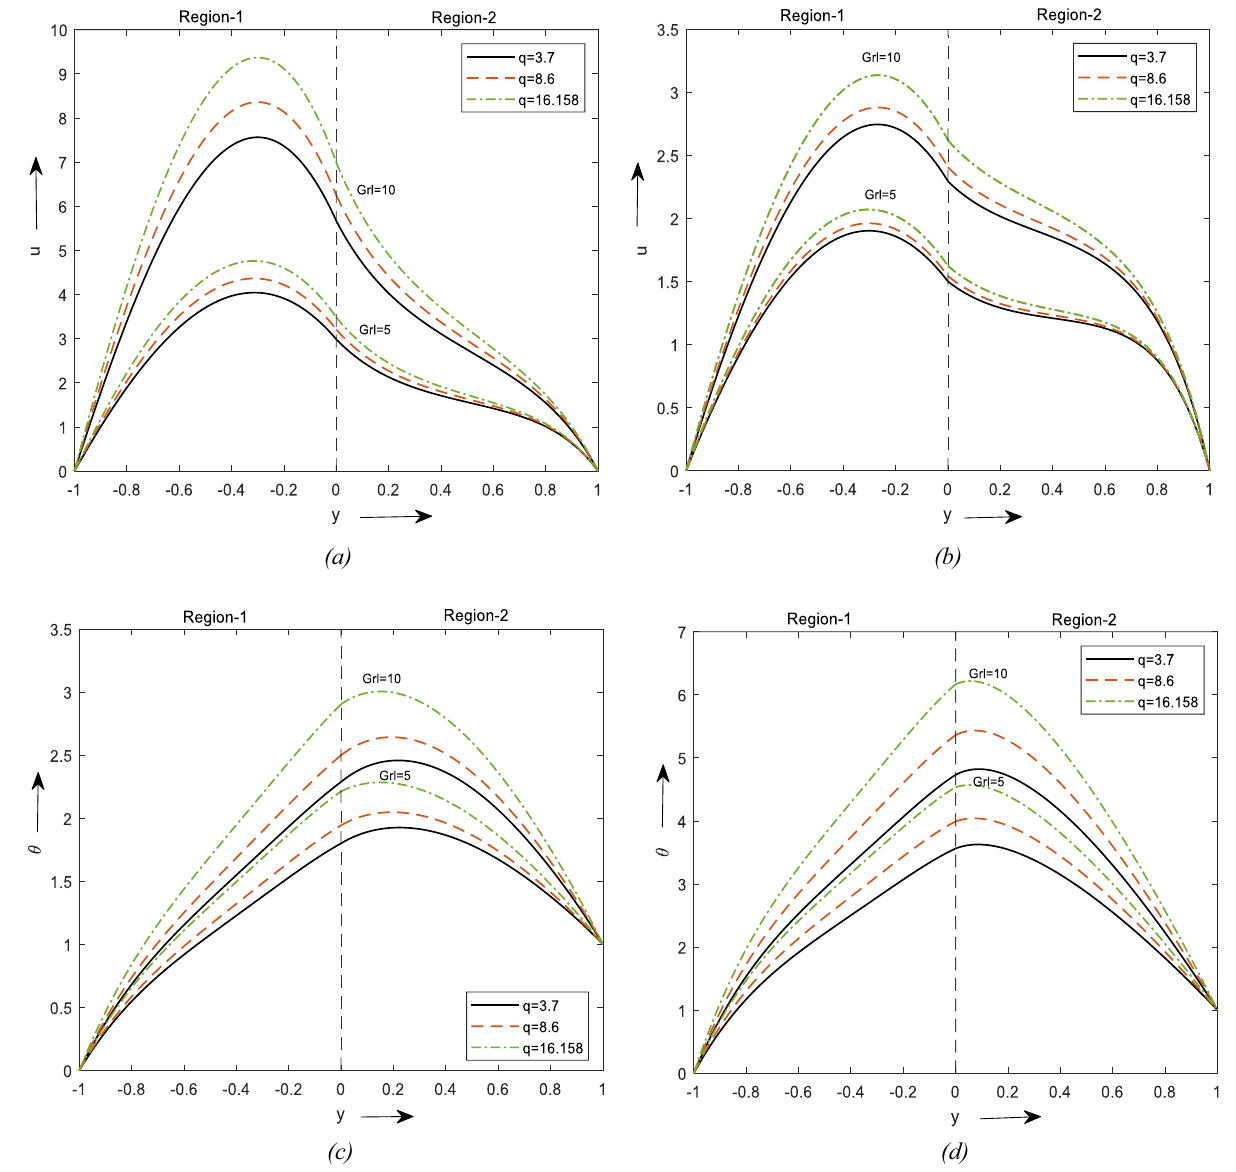
Figure 2. Velocity profiles for different values of Thermal Grashof number. ( a ) For two different values of φ . ( b ) for a value of φ . Temperature profiles for different values of Br. ( c ) For two different values of φ . ( d ) For a value of φ